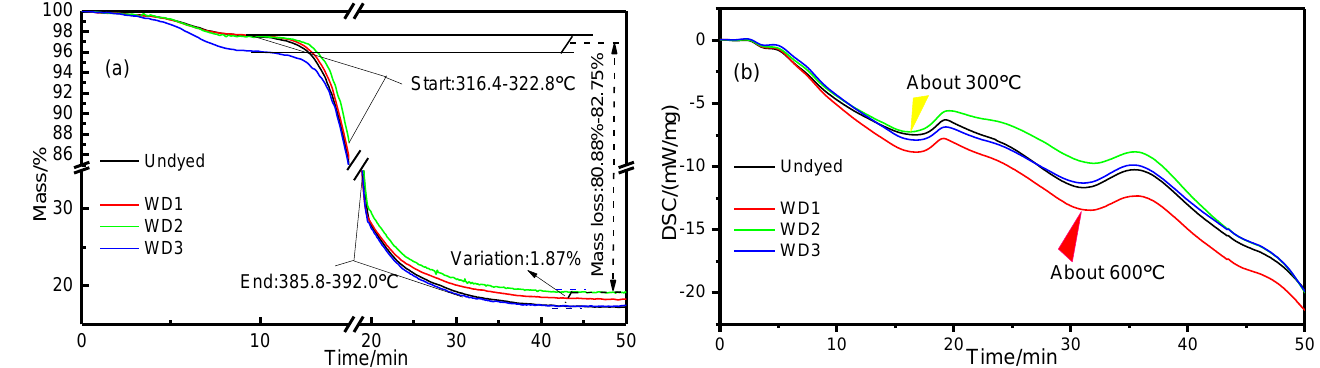
Figure 8. TG ( a )-DSC ( b ) analysis of poplar wood infected for 40 days under different induction factors.